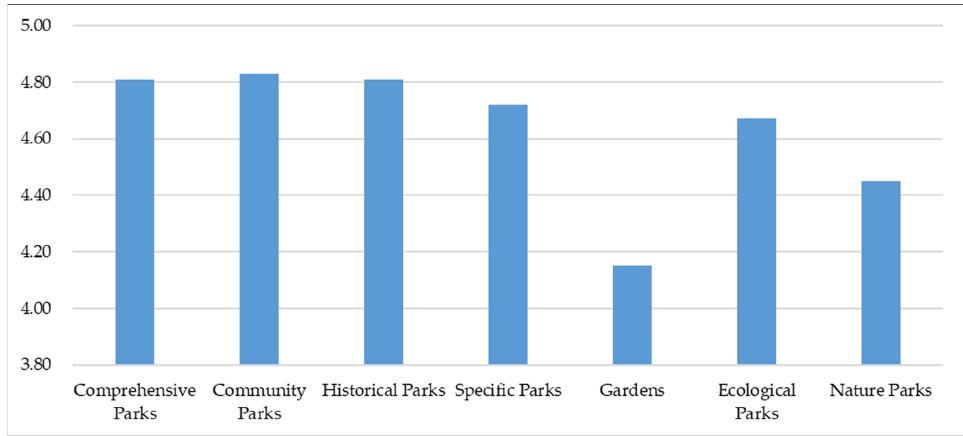
Figure 8. The average stars of riverside parks of different types.